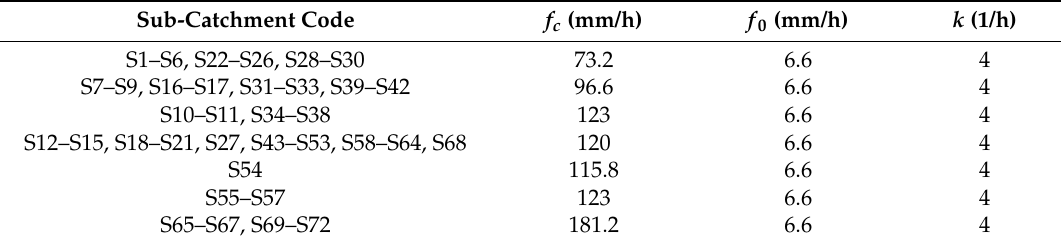
Table 3. Initial values of the infiltration